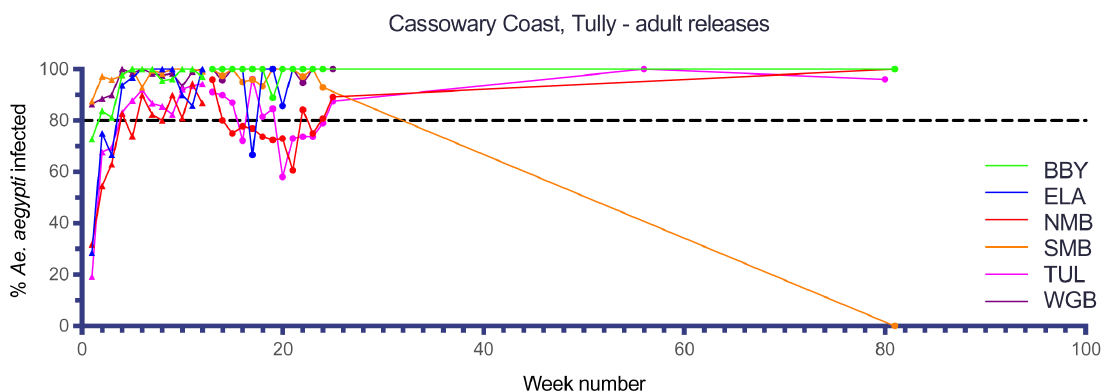
Figure 14. Wolbachia infection rates in Aedes aegypti mosquitoes collected from Bingal Bay (BBY), El Arish (ELA), North Mission Beach (NMB), South Mission Beach (SMB), Tully (TUL) and Wongaling Beach (WGB) during release (triangles) and post-release (circles) monitoring periods ( Wolbachia infected adult releases were undertaken every week for 12 weeks between May–Aug 2017, Week number 1 corresponds to commencement of Wolbachia mosquito